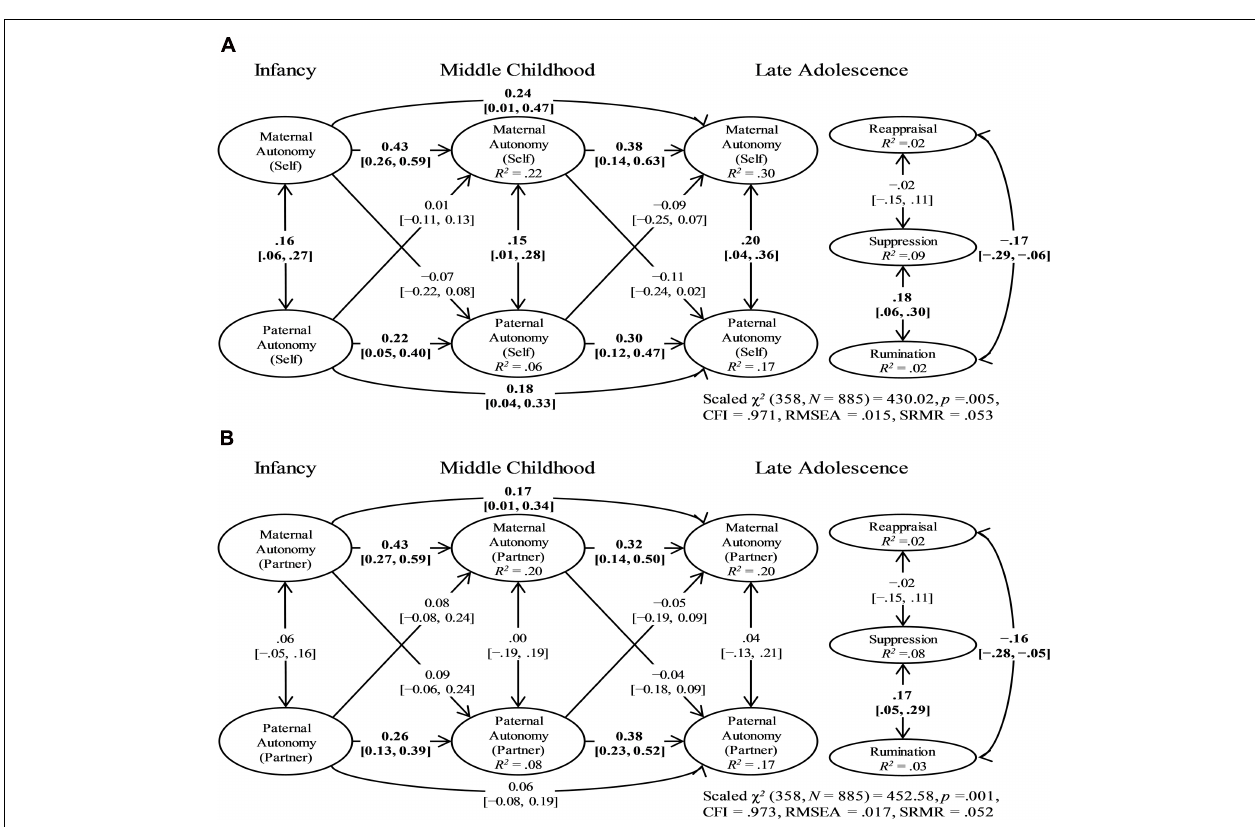
FIGURE 2 | The Final Self-Reported (A) and Partner-Reported (B) Parental Autonomy Models: Standardized Parameter Estimates and 95% Confidence Intervals. There were no effects of maternal or paternal autonomy in infancy, middle childhood, and late adolescence on adolescents’ emotion regulation patterns. Bolded values represent paths in which the 95% confidence interval did not contain zero. The factor loadings and error term correlations of parental autonomy indicators and the path coefficients of covariates are not shown. CFI = robust comparative fit index; RMSEA = robust root-mean-square error of approximation; SRMR = standardized root mean square